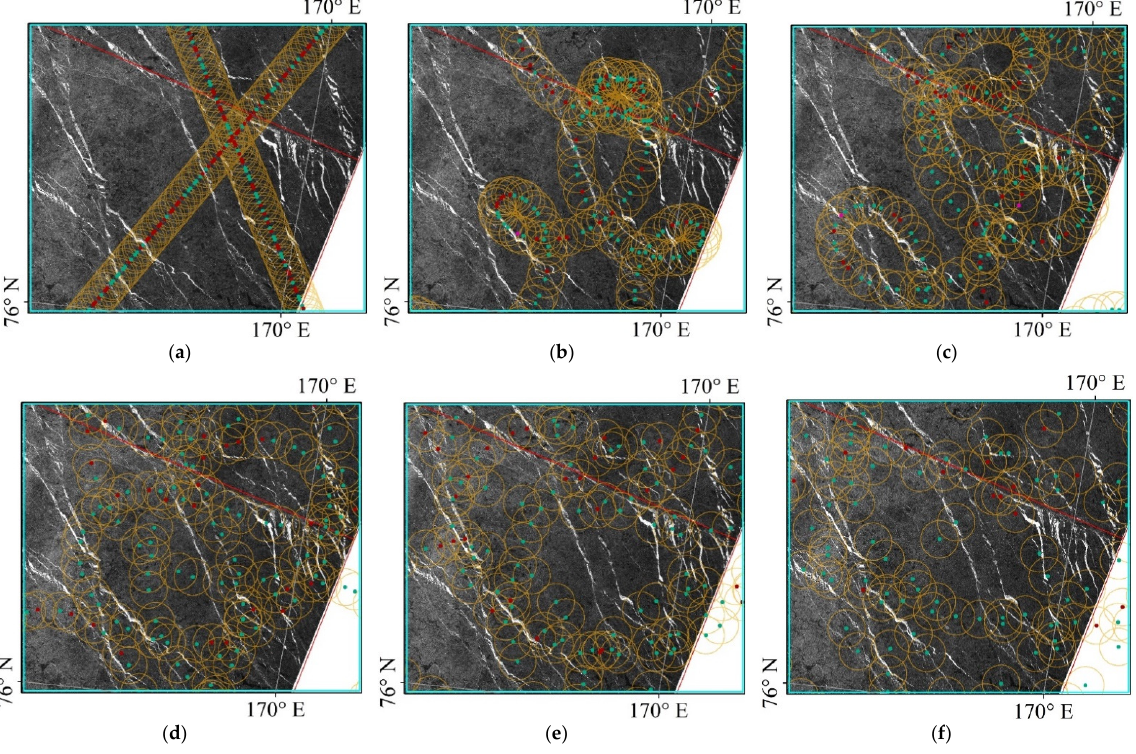
Figure 17. Classification results in the complex area at six incidence angles. Each orange circle represents the coverage of one footprint. ( a ) 0°; ( b ) 2°; ( c ) 4°; ( d ) 6°; ( e ) 8°; ( f ) 10°.